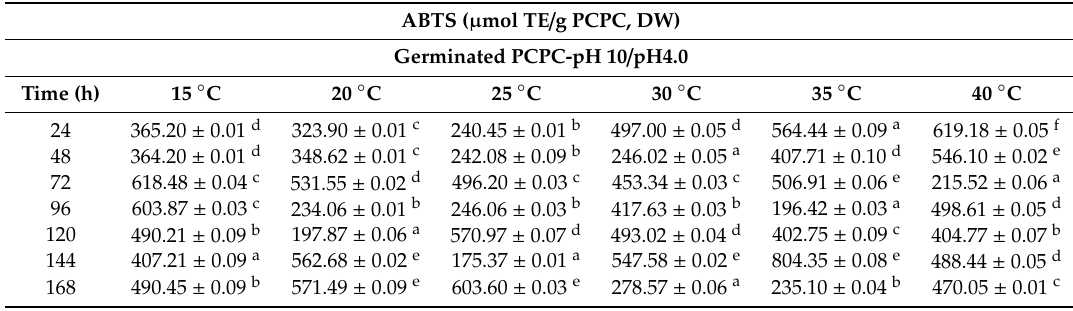
Table 4. PCPC antioxidant activity by the 2,2-azinobis, 3-ethyl-benzothiazoline-6-sulfonic acid, (ABTS)